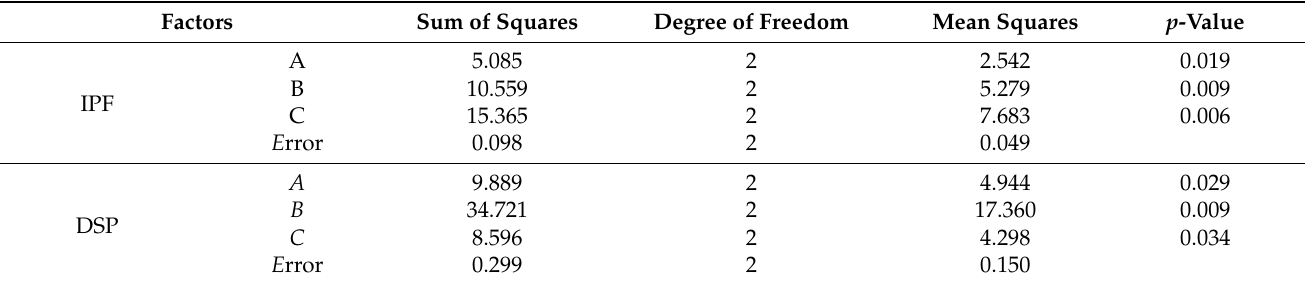
Table 4. Variance analysis of the orthogonal